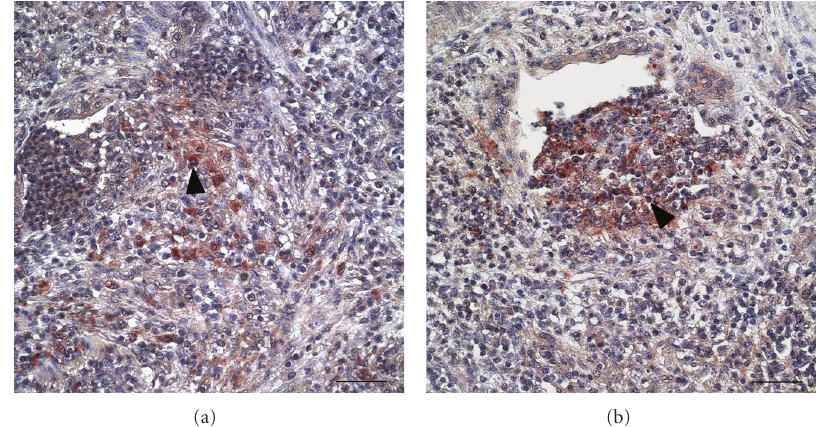
Figure 2: Confirmation of PCV 2 antigen in BOOP lesion. PCV 2 antigen signals appeared strong positive in the foamy alveolar macrophages ((a)-(b), arrow head) and intraluminal plugs of two representing BOOP lesions. The other lung sections in five individual BOOP pigs revealed the similar results ( n = 5, six replicates in each individual pig; Bar = 50 μ